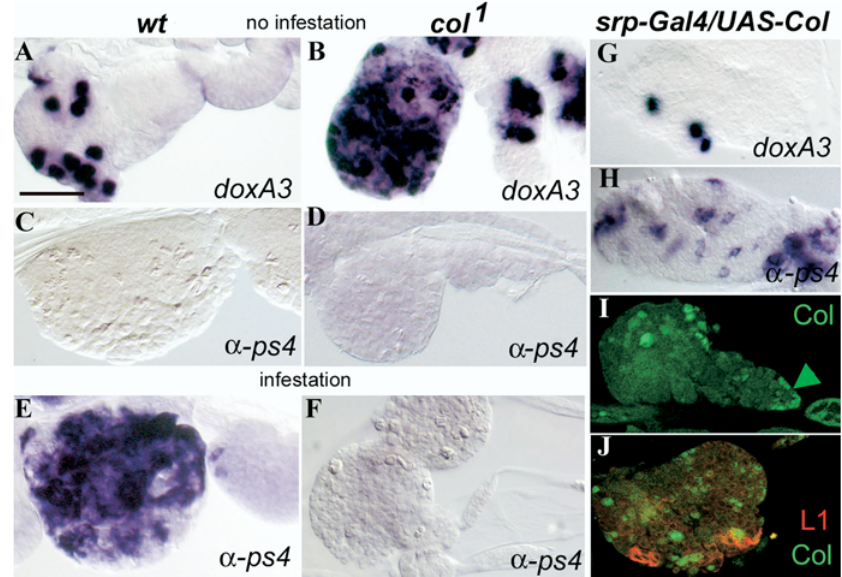
Figure 5. Col-Expressing Cells Play an Instructive Role in Lamellocyte Production Expression of the crystal cell marker doxA3 (Waltzer et al. 2003) (A, B, and G); of the lamellocyte markers a -ps4 (M. Meister, unpublished data) (C–F and H) and L1 (Asha et al. 2003) (J); and of Col (I and J); in wt (A, C, and E), col loss-of- function mutant (B, D, and F), and srp- Gal4/UAS-col (G–J) larvae. In (E) and (F), larvae were taken 48 h after infestation. An increased number of doxA3 -positive cells (B) parallels the absence of lamello- cyte differentiation (F) in col 1 mutant lymph glands. Conversely, lamellocyte differentiation and a reduced number of doxA3 -positive cells are observed upon enforced Col expression (G and